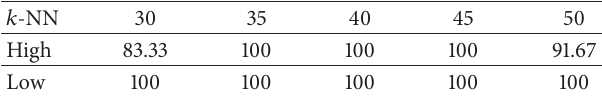
Table 5: The performance of 𝑘 -NN in FSFL model when the 2D LBP scheme is used for feature extraction.